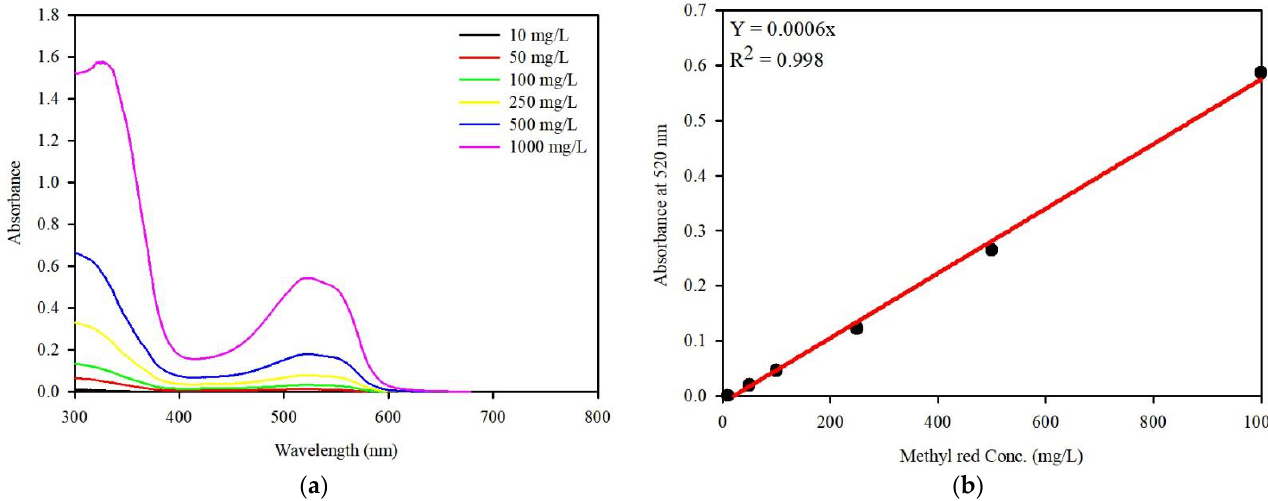
Figure 2. UV-Vis spectrum of MR at ( a ) various concentrations and ( b ) calibration curve for MR.